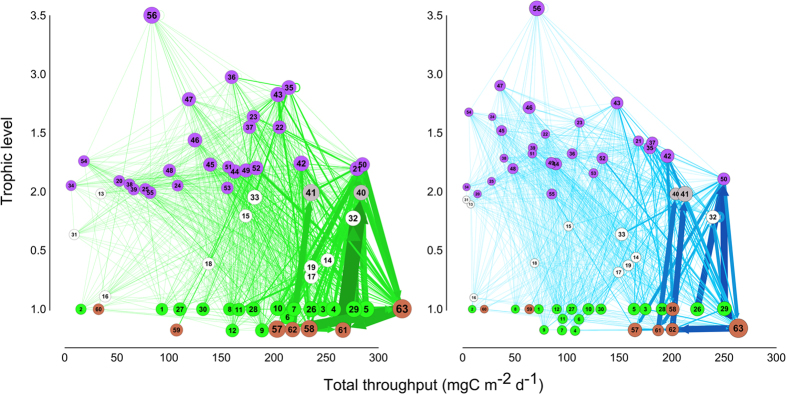
Green and blue plankton food webs.Node colors distinguish non living (brown), primary producers (green), mixotrophic groups (light grey) and consumers (purple). Node size is proportional to log biomass and edge size is proportional to flows. Groups are displaced in xy space by TL (y-axis) and log total throughput of the node (x-axis). Some groups, conventionally at TL = 1 are displaced at lower TL for clarity.